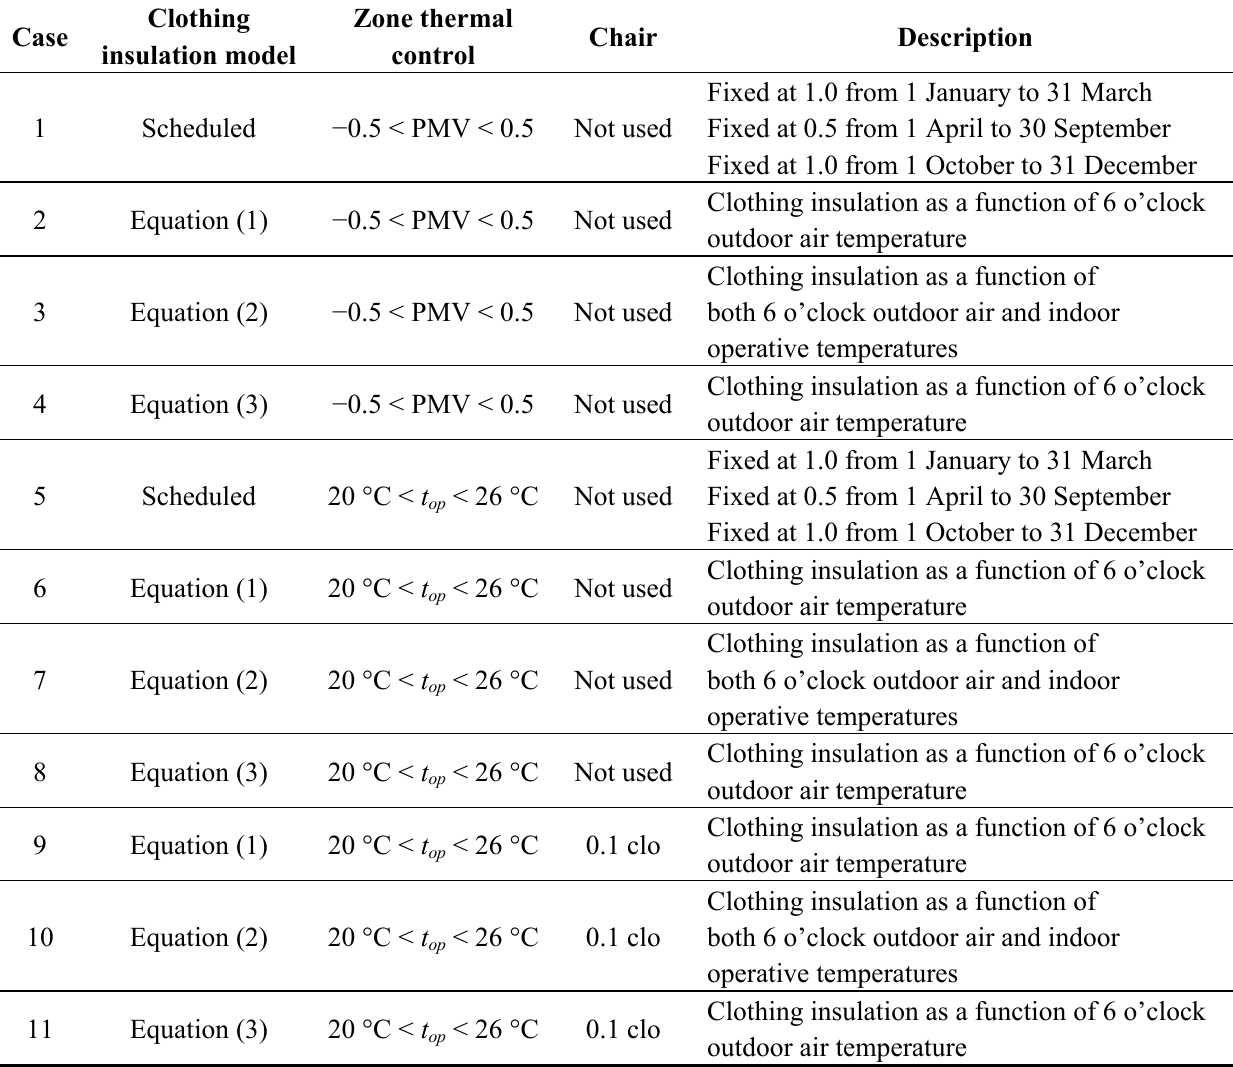
Table 3. Simulated